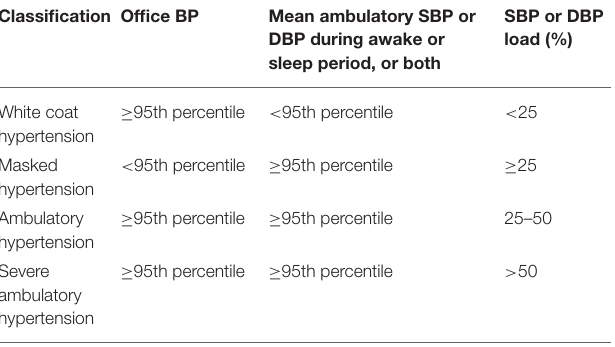
TABLE 2 | Suggested schema to classify blood pressure in children (34).